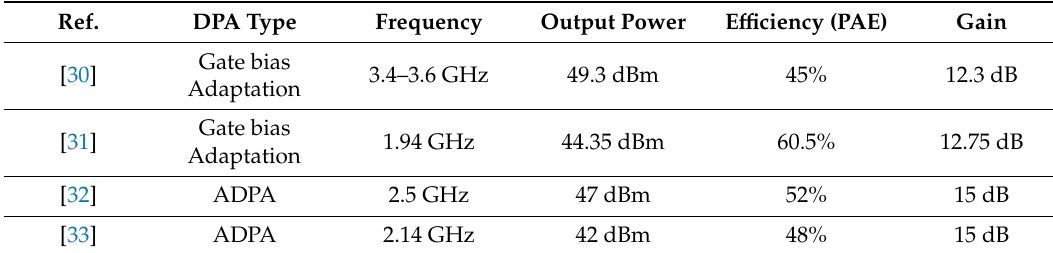
Table 2. Measured performance summary of similar topology DPAs.